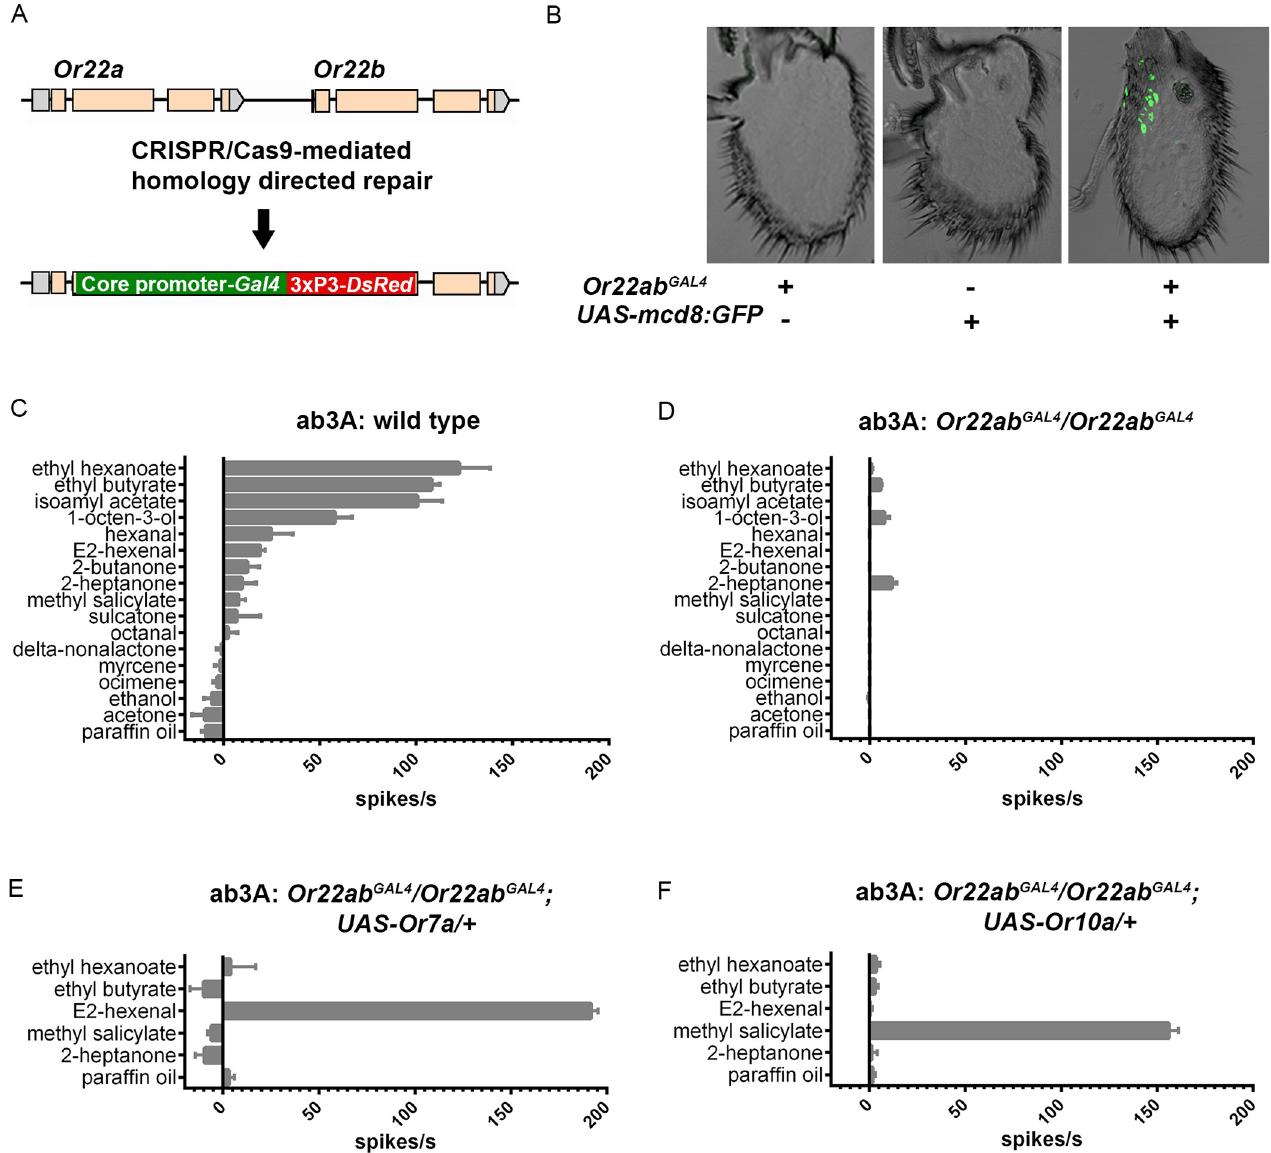
Fig 7. CRISPR/Cas9 knock-in of the Gal4 gene into the Or22a and Or22b coding regions. (A) Genomic region of Or22a and Or22b before and after it is targeted for CRISPR/Cas9-mediated homology-directed repair to knock-in the Gal4 transcription factor and DsRed eye marker genes. The formal designation of this stock is Df(2L)Or22ab , TI{GAL4}Or22ab but for convenience it is indicated as Or22ab GAL4 . (B) GFP signal from antennal cross sections from D . melanogaster carrying the Gal4 knock-in (Or22ab GAL4 ) , the UAS-mcd8 : GFP transgene on the second chromosome, or both. (C, D) Odorant response profiles from (C) wild type control ab3A and (D) homozygous Or22ab GAL4 ab3A ORNs. (E, F) Odorant response profiles from D . melanogaster UAS-Or transgenes previously shown [15] to confer strong responses to E2-hexenal (Or7a) (E) or methyl salicylate (Or10a) (F), expressed in homozygous Or22ab GAL4 ab3A olfactory receptor neurons. In panels C-F neuronal responses are reported in spikes/second +/- S.E.M., using individual odorants diluted at 10 − 2 and presented for 0.5 seconds. n � 5 for all odorants tested. Spontaneous firing frequencies have been subtracted from all responses; responses to the paraffin oil diluent have been subtracted from the responses to all